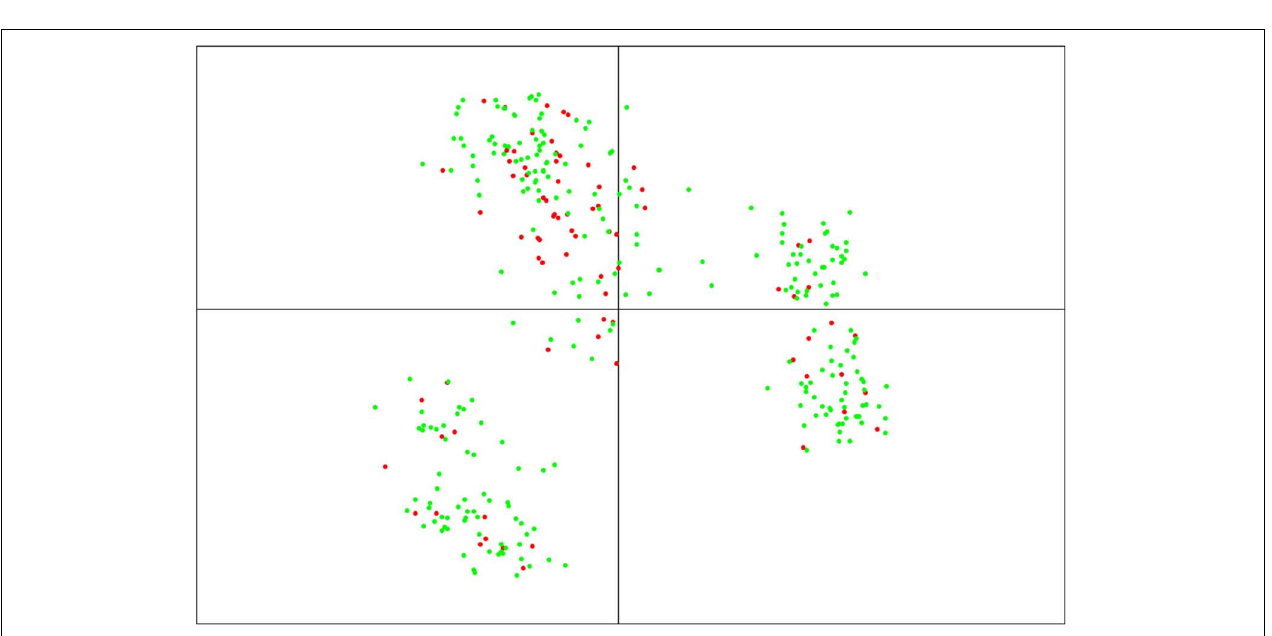
FIGURE 2 | Benchmarking of different methods for optimizing TPs of MAGIC. Bars of different colors report the values of predictive ability obtained with GP models fitted using CD_mean (CD), prediction error variance (PEV), rScore and Diverse optimization criteria. The error bars of each plot point out the standard deviation of the predictive ability